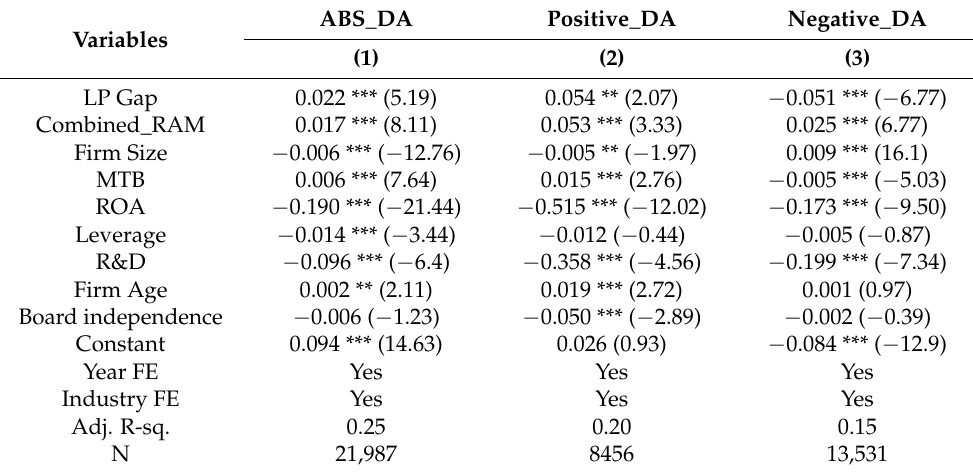
Table 3. Accrual-based earnings management on labor productivity gap. (** indicates level of significance at 95% level and *** indicates level of significance at 99%